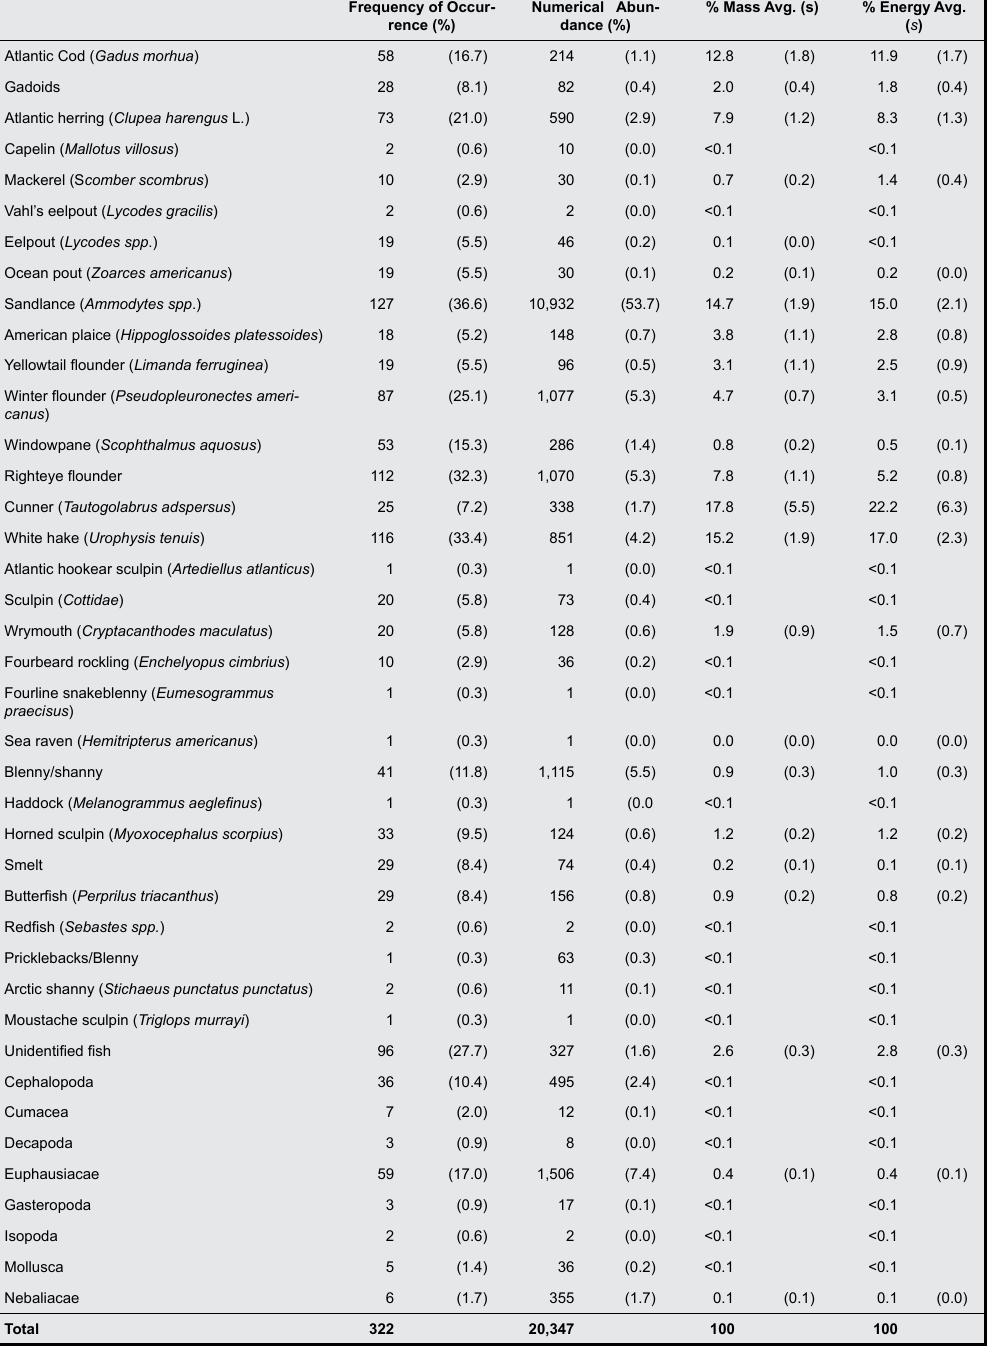
Table 5 . Diet composition of 322 seals collected from the southern Gulf of St. Lawrence be- tween 1994 and 2003. Frequency of occurrence and % frequency of occurrence in parentheses, numerical abundance with relative percent in parentheses, and percent (%) mass and energy contribution to the diet with standard deviation in